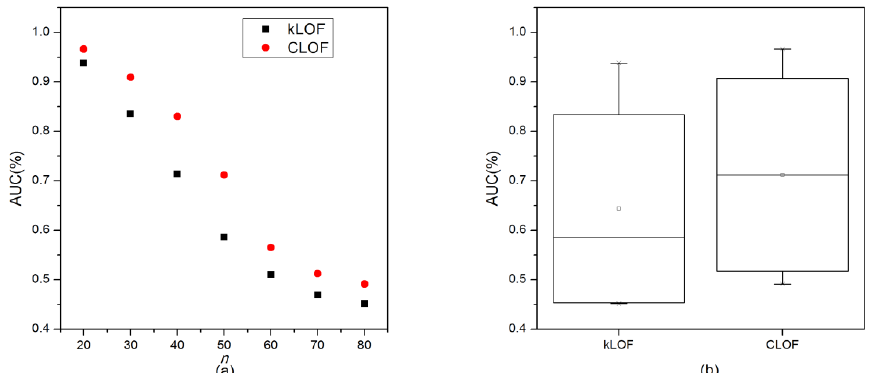
Figure 13. AUC values of kLOF and CLOF methods on the KDD Cup 1999 dataset with different n related to t , and the box plots for kLOF and CLOF: ( a ) the AUC values of kLOF and CLOF methods; ( b ) the box plots for kLOF and CLOF methods.